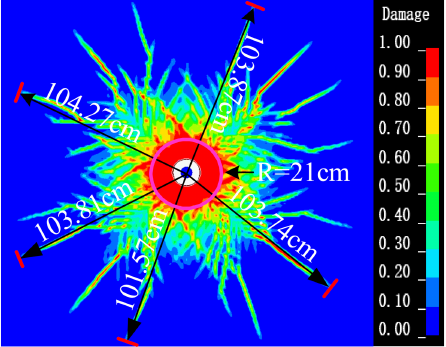
Figure 3. Simulated crack propagation diagram of single-hole blasting.